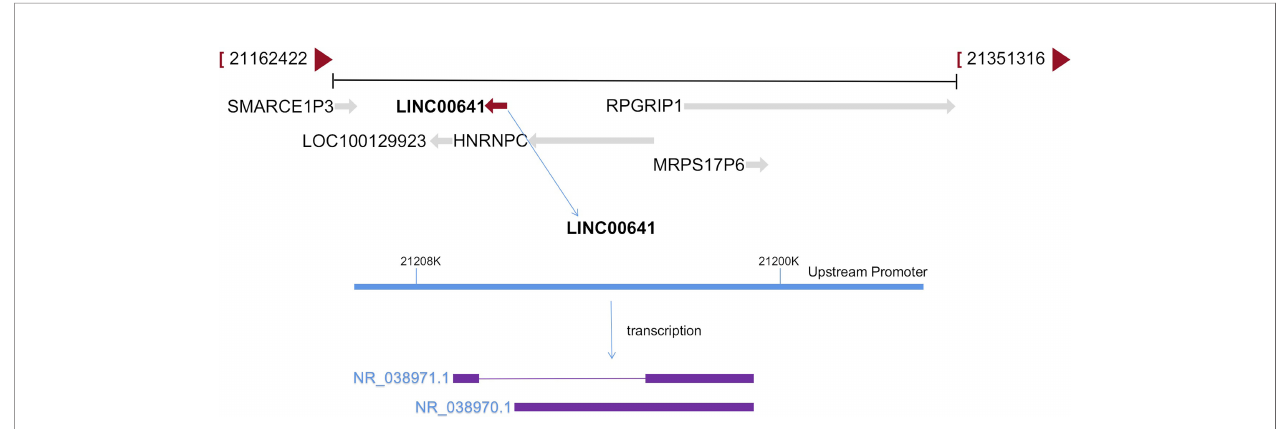
FIGURE 2 | LINC00641 formation diagram.